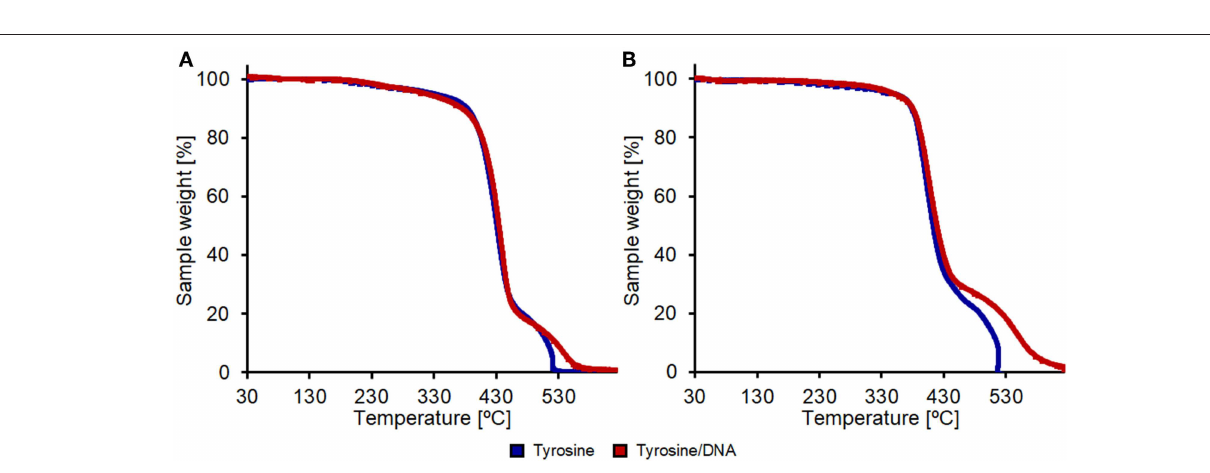
The brownish color of theburned parts, which results from sugars presence of DNA on the nylon